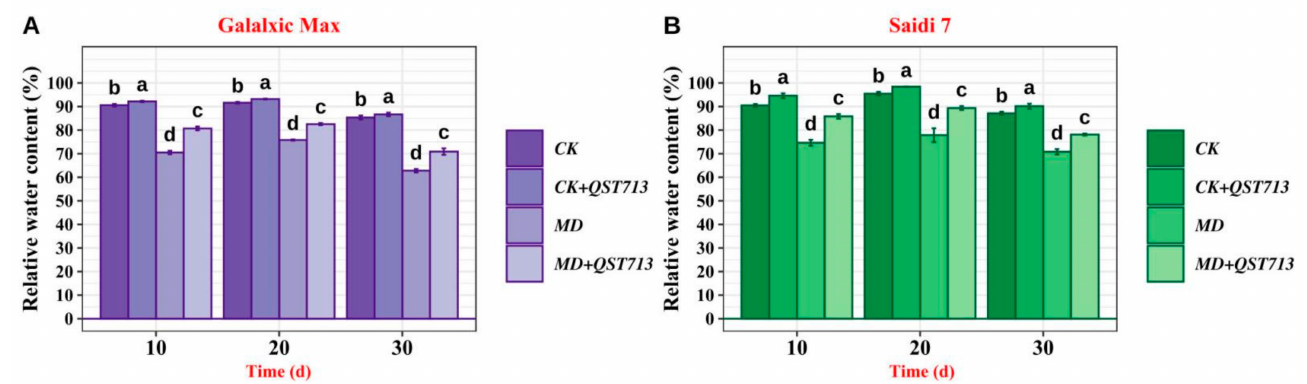
Figure 1. Effect of drought stress and QST713 application on the leaf relative water content (RWC) of alfalfa seedlings in two cultivars (( A ) Galalxic Max; ( B ) Saidi 7). Data are the mean ± SE ( n = 3). Different letters indicate significant differences from each other ( p < 0.05).